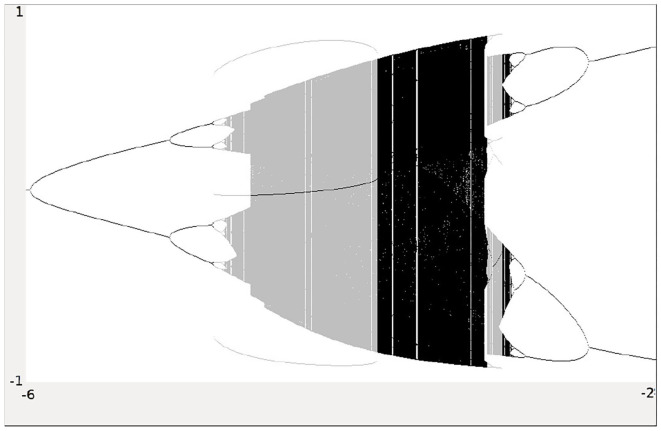
Bifurcation diagram for the varied bias term θ1 of the synchronous dynamics according to w+ given by (27). The bias term θ2 = 0 is fixed. Shown is the mean output o¯=0.5·(o1+o2) of the 2-neuron module corresponding to the synchronization core CS(w+) in Figure 5 (right). Coexisting attractors are marked by gray shaded domains.